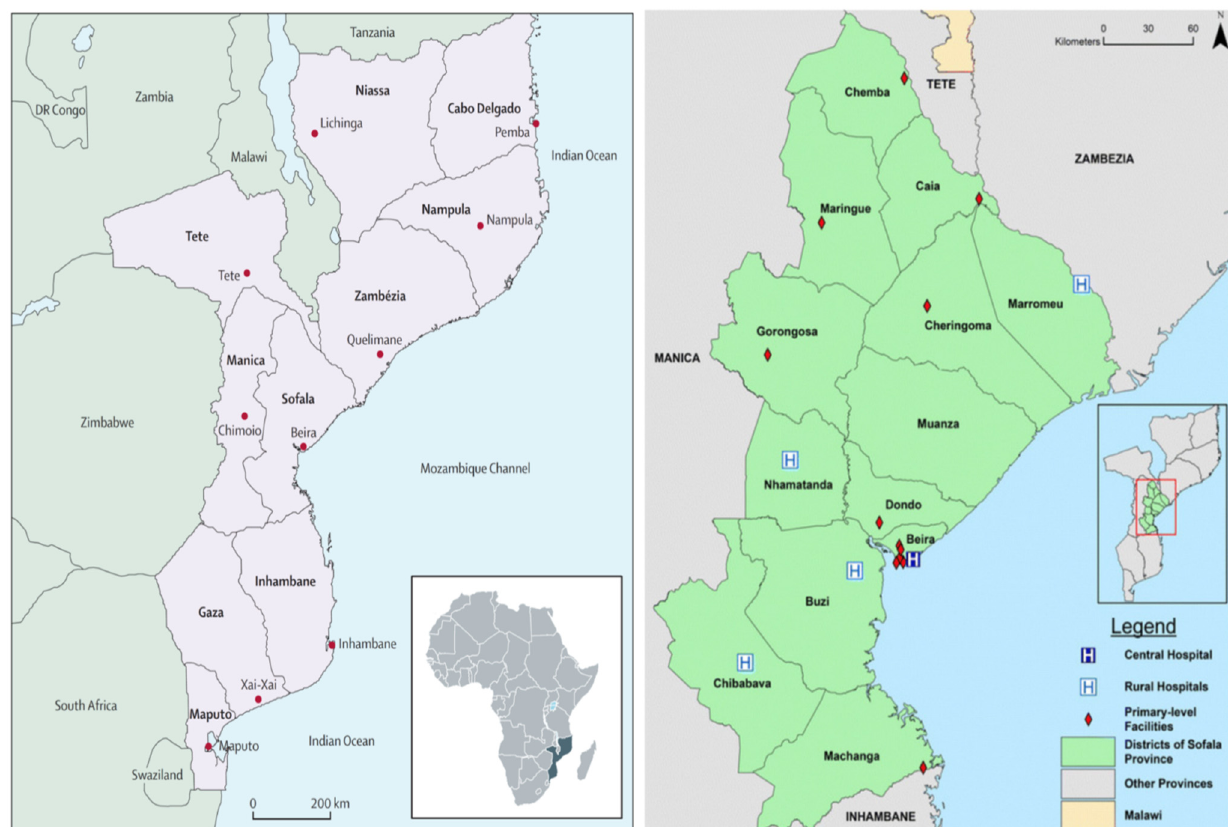
Figure 1. Map of Mozambique and Districts Headquarters Health Facilities in Sofala. Source: adapted from https://www.ncbi.nlm.nih.gov/pmc/articles/PMC4158849 (accessed on 16 May 2022); https://bmcpsychiatry.biomedcentral.com/articles/10.1186/s12888-015-0609-4 (accessed on 16 May 2022). The health facilities above illustrated have at least 1 technician of psychiatry and mental